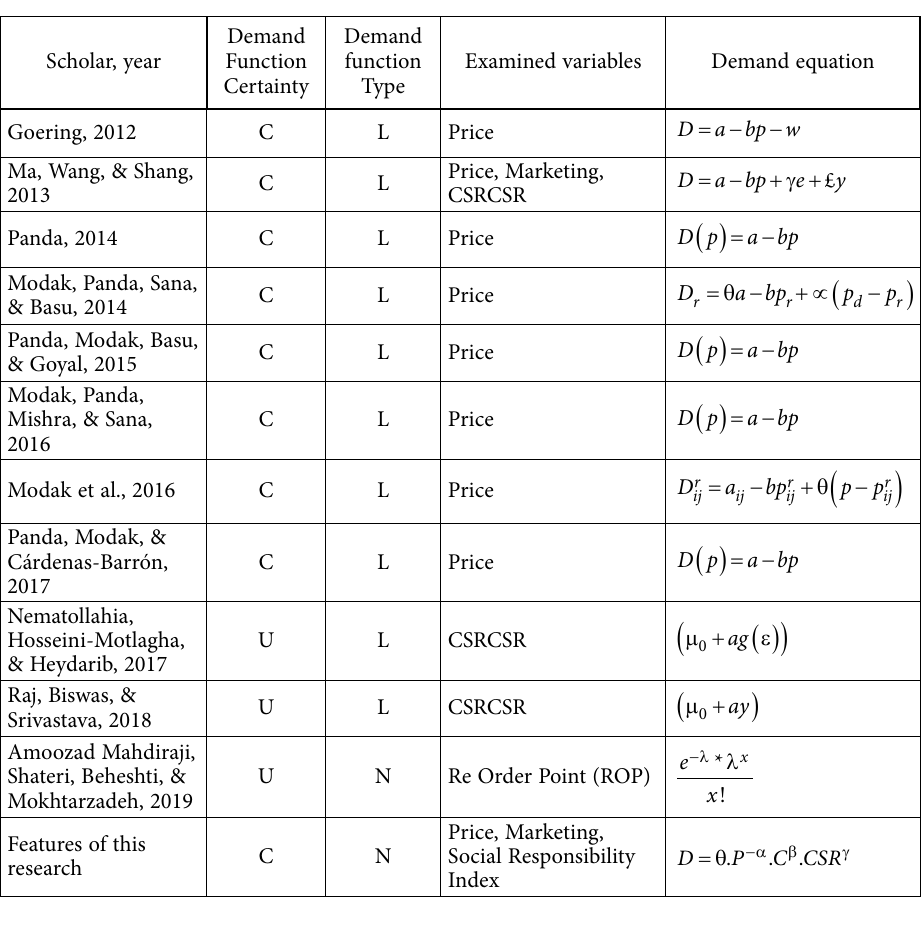
Table 2. Demand functions employed in supply chains